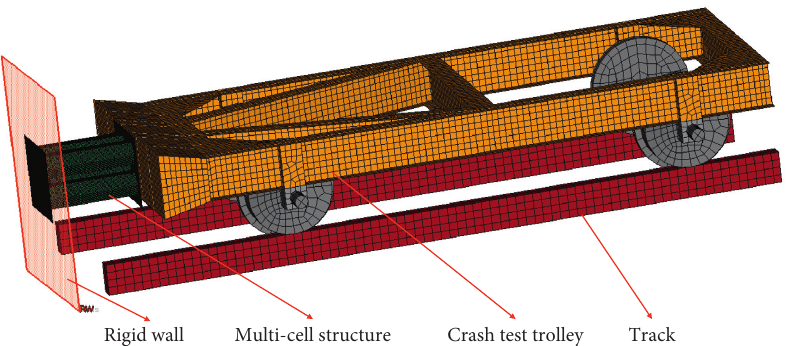
Figure 3: FEM and boundary conditions.